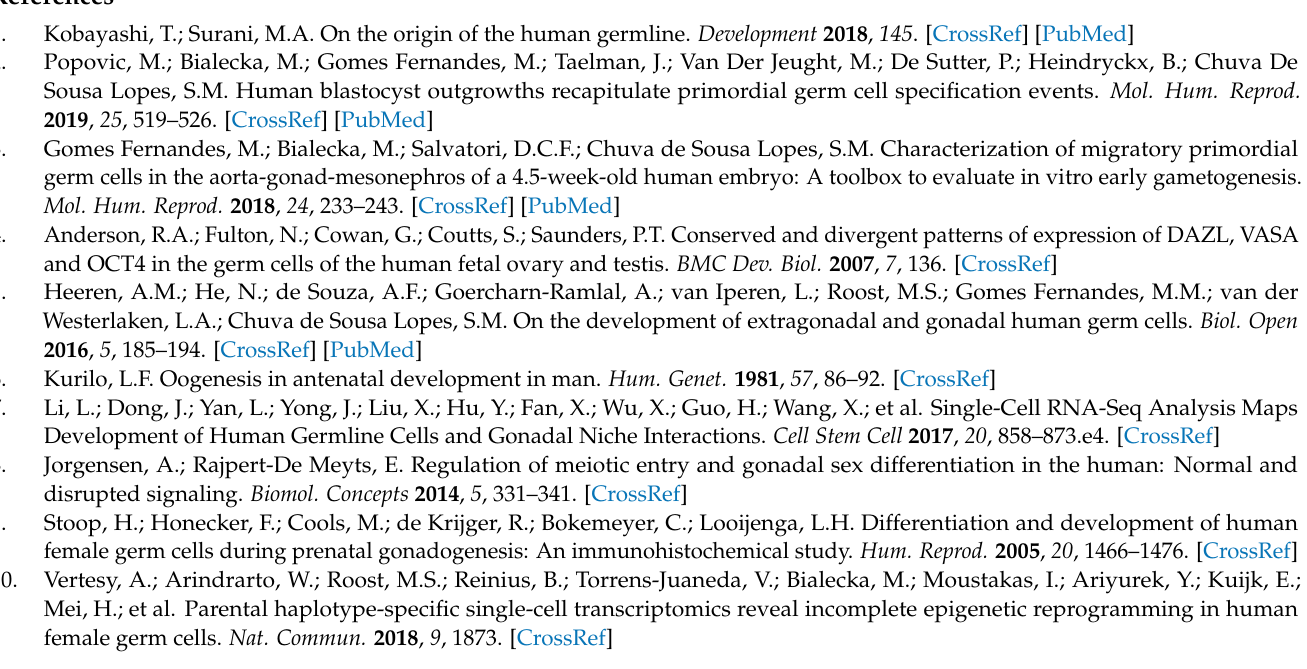
FACS. Table S2: list of differentially expressed genes between male mitotic and female mitotic